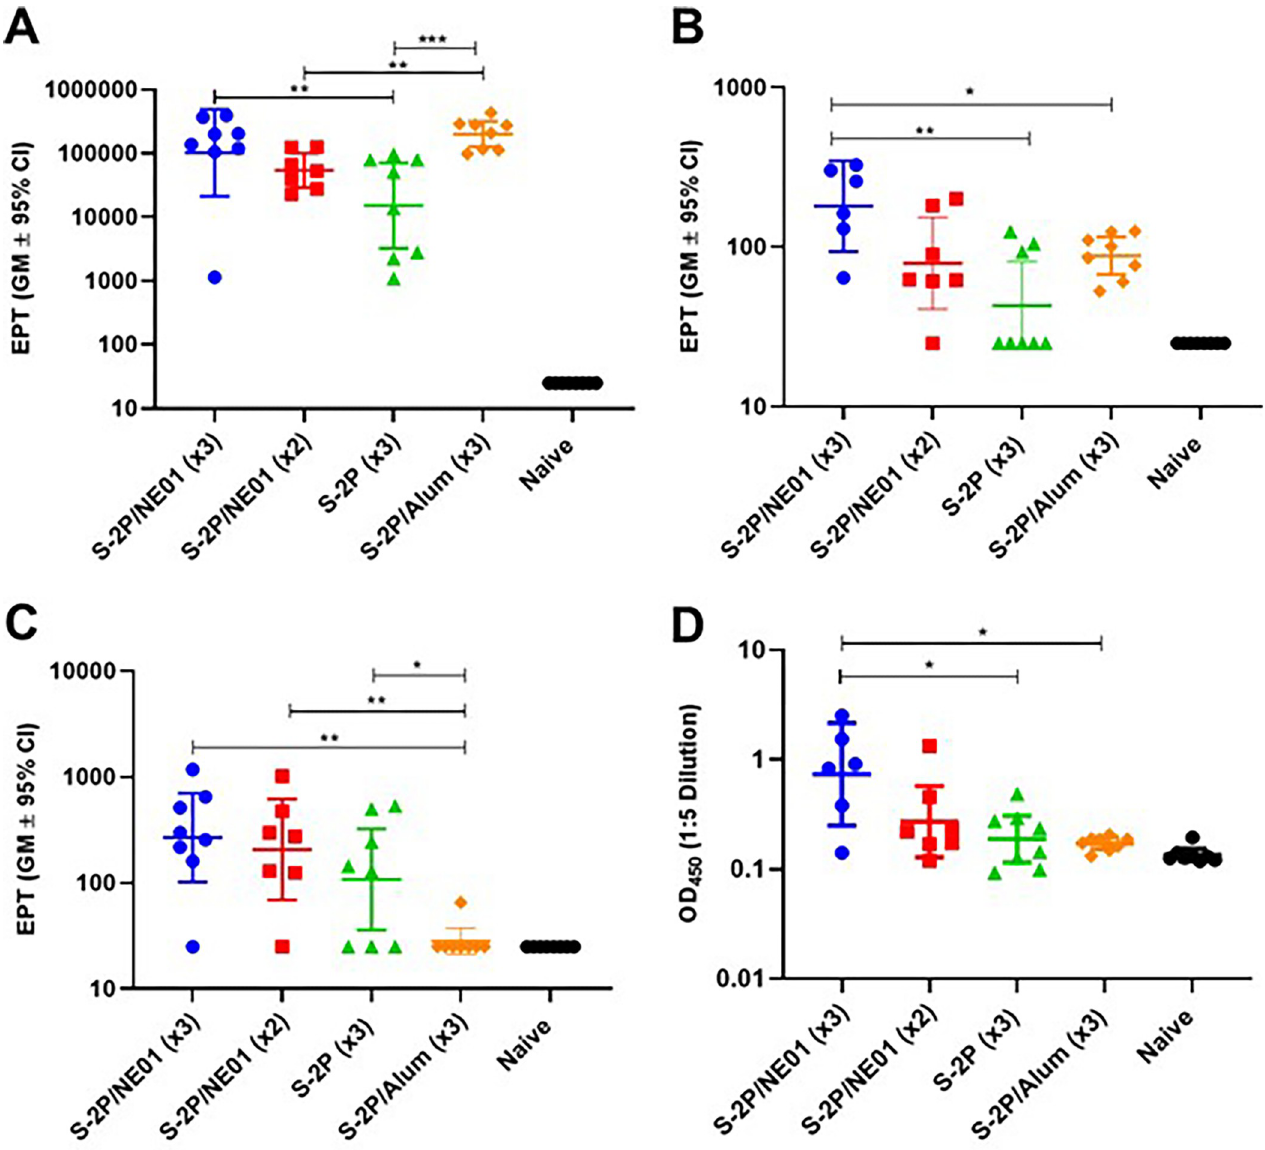
Fig 1. Humoral immune response in mice following immunizations with S-2P. Humoral immune responses elicited in mice after immunizations with IN or IM formulations of S-2P as determined by A-B) Serum and BAL S-2P specific IgG End point titers (EPT). C) Serum IgA EPT and D) BAL IgA OD values. Statistical analysis was performed using Mann-Whitney nonparametric test for unpaired data, � p < 0 . 05 , �� p < 0 . 01 , ��� p < 0 . 001 .